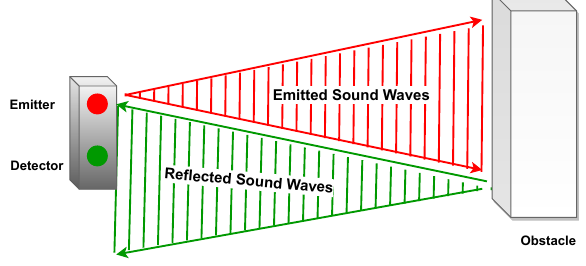
Figure 4. Principle of ultrasonic testing.